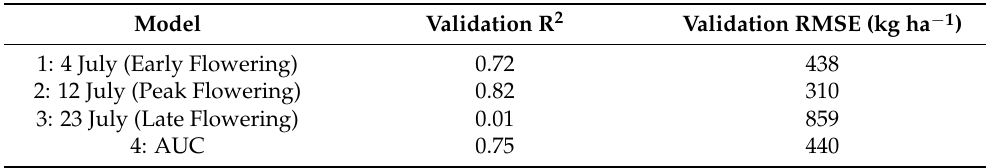
Table 7. Pearson’s correlation coefficient (R) and root mean squared error (RMSE) of the validation plots from the four canola seed yield